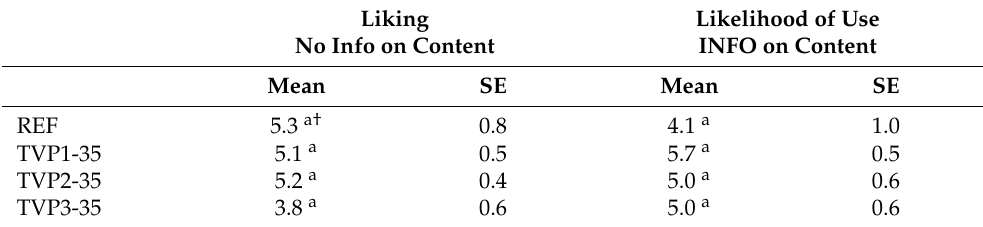
Table 4. The samples’ average liking rating on a modified 9-point hedonic scale and standard error (SE). A paired t -test was used to test for significant effects of providing information. Liking No Info on Content